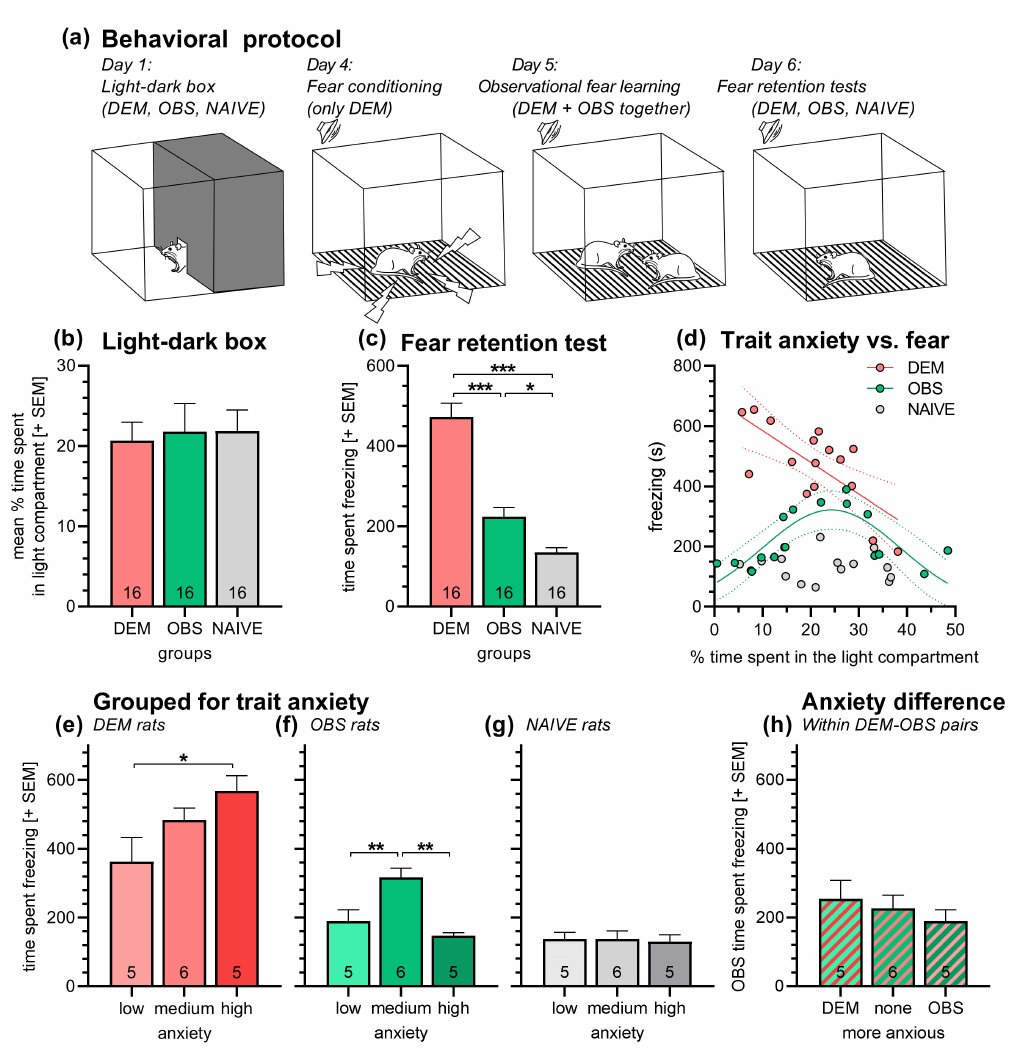
Figure 1. Role of trait anxiety in observational fear learning. ( a ) Behavioral protocol (for more details, see Materials and Methods): After a light–dark box test, rats were divided into three groups (“demonstrator” (DEM), “observer” (OBS), “naive” (NAIVE)) with similar anxiety levels. DEM rats were fear-conditioned. One day later, the DEM and OBS pairs were exposed to the conditioning boxes. Last, all rats were individually tested for conditioned fear. ( b ) Mean percent time spent in the light compartment of the light–dark box. DEM, OBS, and NAIVE rats had similar anxiety levels. ( c ) DEM rats expressed more freezing in the retention test than rats of the two other groups. Importantly, OBS rats had significantly higher freezing scores than NAIVE rats, indicating observational fear learning in OBS rats. ( d ) Freezing scores as a function of trait anxiety (more% time spent in the light compartment indicate less anxiety). In DEM rats, higher freezing scores could be observed with higher trait anxiety. In OBS rats, a bell-shaped correlation was found, freezing was highest with a medium levels of trait anxiety. These correlations were confirmed by grouping the animals into low, medium, and high anxiety. ( e ) High anxious DEM rats had significantly higher freezing scores than low-anxiety DEM rats. ( f ) Medium anxious OBS rats had significantly higher freezing scores than low- and high-anxiety OBS rats. ( g ) Trait anxiety did not affect freezing scores in NAIVE rats. ( h ) The difference of trait anxiety within a DEM-OBS pair did not influence freezing scores in the retention test. In this analysis, the DEM-OBS pairs were separated into subgroups in which DEM rats being more anxious than the OBS rat (“DEM more anxious”), DEM and OBS rats that were similarly anxious (“none more anxious”), and OBS rats that were more anxious than the DEM rats (“OBS more anxious”). Abbreviations: DEM, demonstrator rats; OBS, observer rats; NAIVE, naive rats. Numbers in the bars indicate group and subgroup sizes. *** p < 0.001, ** p < 0.01, * p < 0.05; comparisons as indicated, after significant main effects in